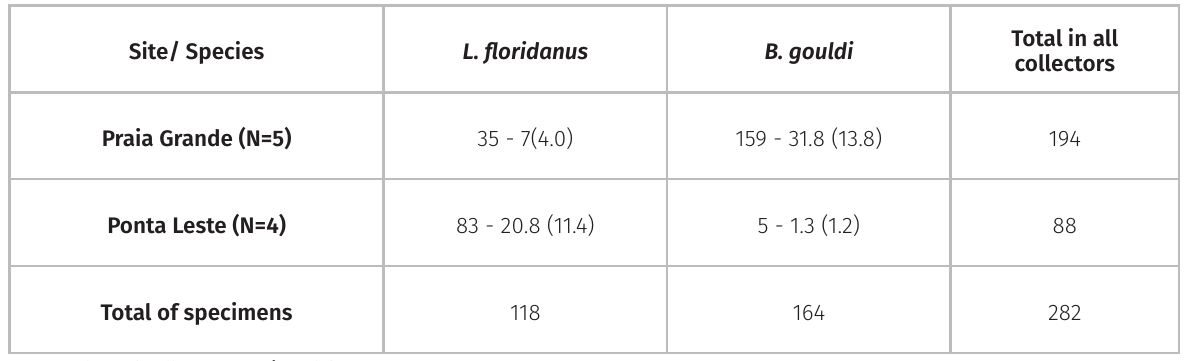
Table I. Total number of individuals, mean number of Teredinidae individuals and (standard deviation between bracket) found at Arraial do Cabo and Ilha Grande